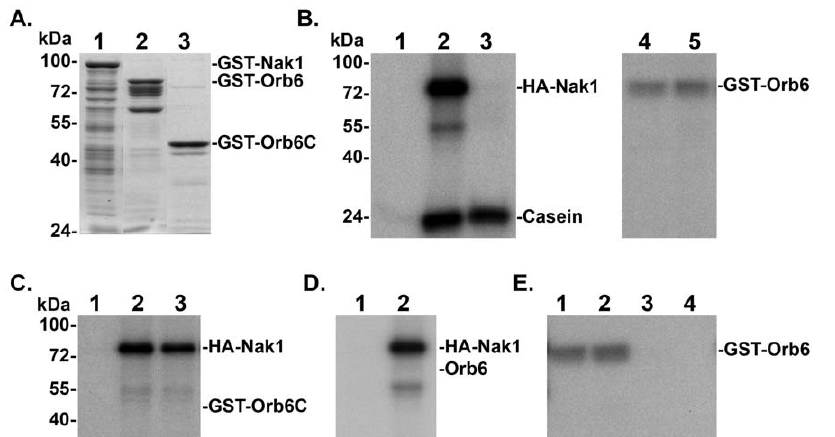
Figure 4. Orb6 phosphorylation invitro . A. Coomassie blue staining of purified recombinant GST-Nak1 (lane 1), GST-Orb6 (lane 2), GST-Orb6 301– 469 (GST-Orb6C) (lane 3). B. Kinase assays were performed using purified recombinant GST-Orb6 and immunoprecipitated HA-Nak1 from yeast cell extracts (Materials and Methods). Protein A-Sepharose beads bound with HA-Nak1 were removed from samples in lanes 3, 5 following the kinase reaction. HA + Casein (lane 1), HA-Nak1 + Casein (lane 2), HA-Nak1 + Casein (lane 3), HA + GST-Orb6 (lane 4), HA-Nak1 + GST-Orb6 (lane 5). C. Kinase assays were performed using purified recombinant GST-Orb6C and immunoprecipitated HA-Nak1 from yeast cell extracts. HA (lane 1), HA-Nak1 (lane 2), HA-Nak1 + GST-Orb6C (lane 3). D. Kinase assays were performed using purified Orb6 lacking GST and immunoprecipitated HA-Nak1. HA + Orb6 (lane 1), HA-Nak1 + Orb6 (lane 2). E. Kinase assays were performed using purified recombinant GST-Orb6 (lane 1), GST-Orb6 T456A (lane 2), GST- Orb6 S291A (lane 3) and GST-Orb6 K122A (lane 4).